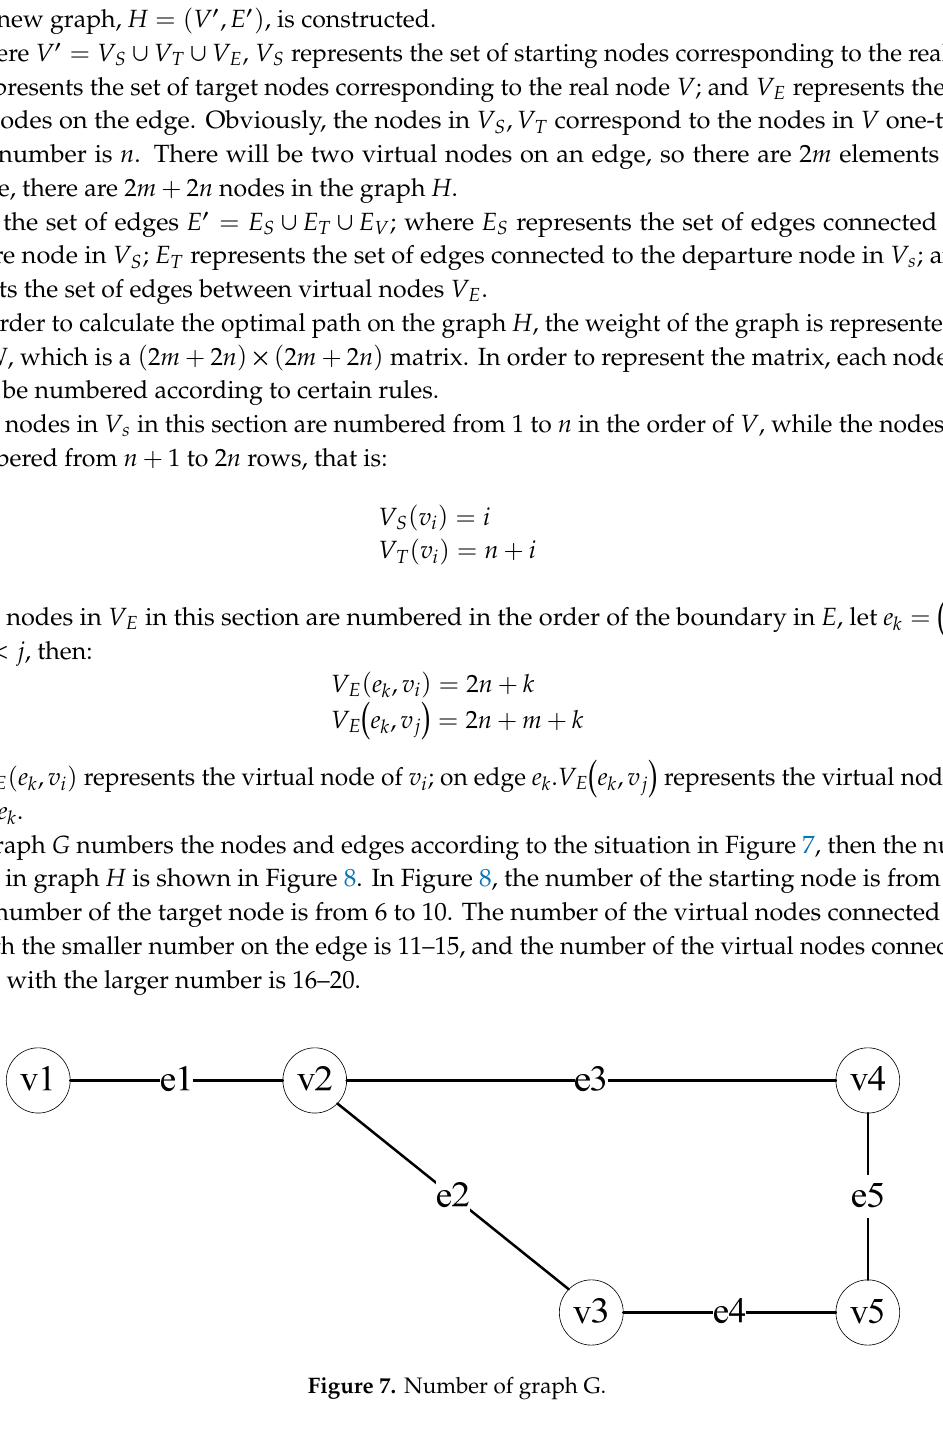
Figure 8. Number of graph H. After numbering the nodes in the graph H , we can follow the rules described in Section 2.2.1 to give the weight matrix W of the graph H satisfying Equation (5): (